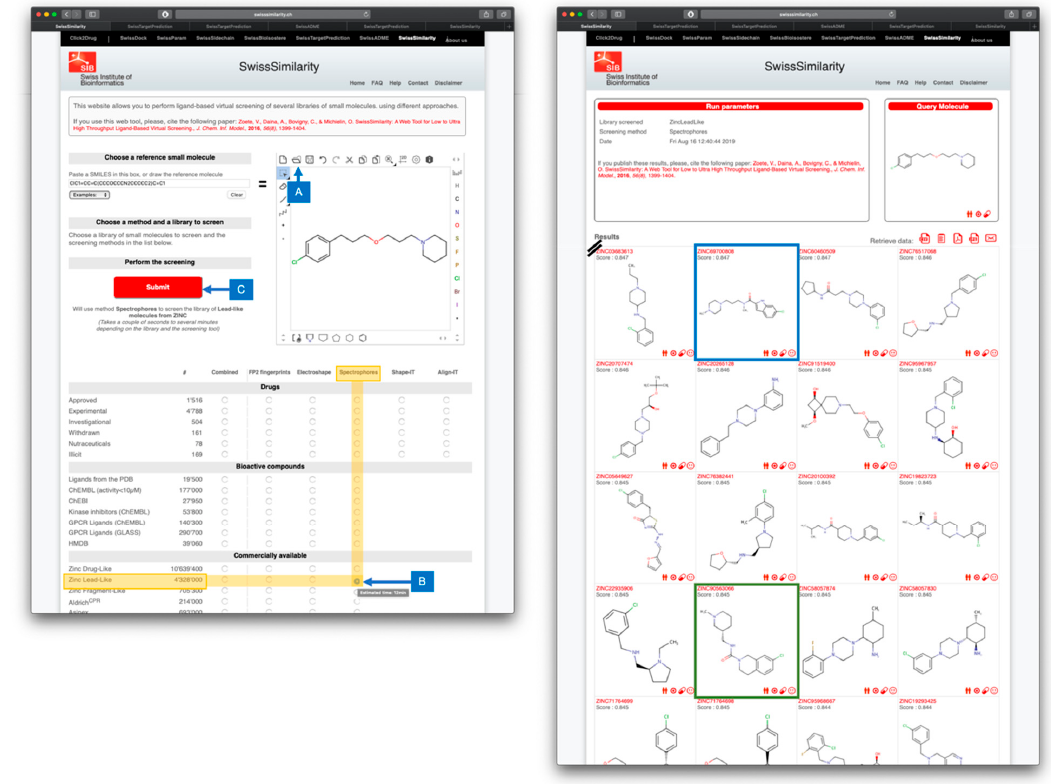
Figure 2. Example of LBVS by using the SwissSimilarity web tool, as in ref [57]. The left panel shows the input of the query molecule; here pitolisant can be entered by its common name, by making use of the import feature of Chemaxon Webservices (A). The method (here Spectrophores) and the database to screen (here the lead-like subset of ZINC) are boxed in yellow showing the corresponding radio button (B). Leaving the mouse over it gives an estimate of the computation time (here 12 minutes for 4,328,000 compounds). By clicking the radio button, the submission button becomes red and active (C) and the parameters selected for screening are written in full. The user can freely click on Submit to launch the calculation. The right panel displaying the result of the screening appears automatically at the end of the calculation, as another web page. The authors selected compounds ZINC69700808 (ranked #62 with a similarity score 0.847, boxed in blue) and ZINC905630066 (ranked #74 with a similarity score 0.845, boxed in green) according to subsequent analyses, including reverse LBVS with SwissTargetPrediction and pharmacokinetic parameters estimation with SwissADME. Both compounds were validated experimentally in vitro as submicromolar inhibitors of the histamine H 3 receptor.